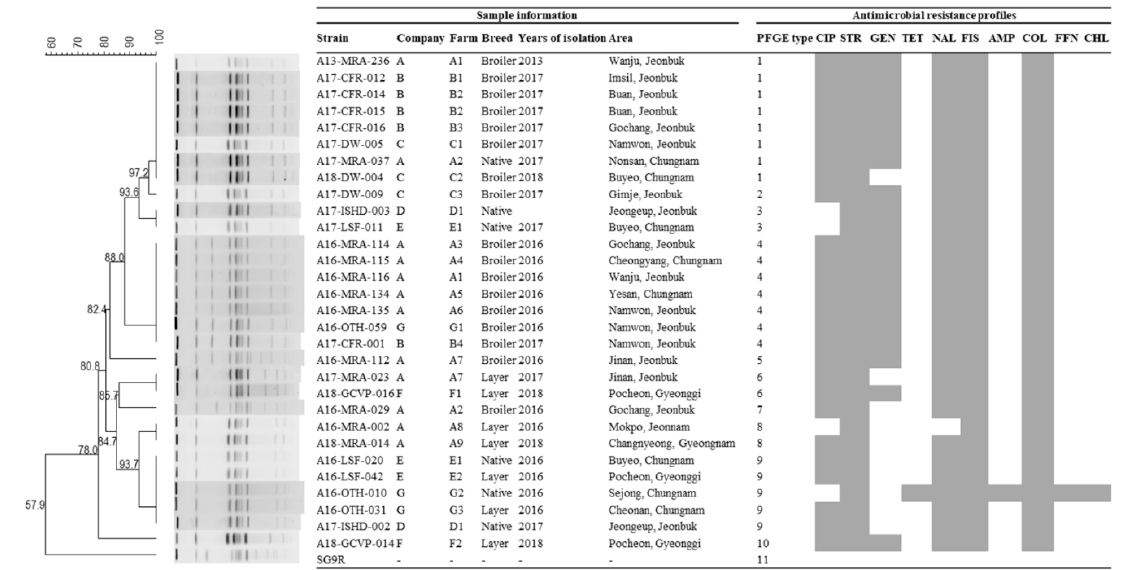
Figure 1. A dendrogram based on the Xba I-pulsed field gel electrophoresis (PFGE) profiles of S.